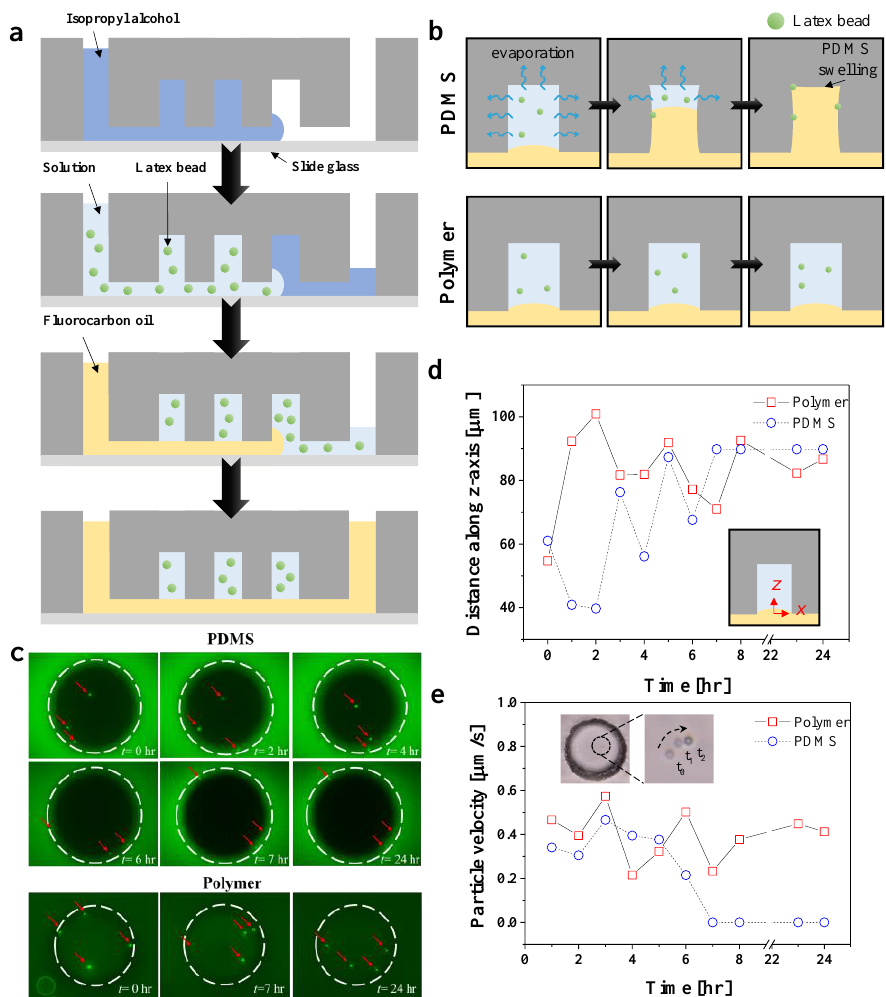
Figure 5. ( a ) Schematic illustration of particle compartmentalization. In order to visualize the evaporation of microchambers, latex beads expressing green fluorescence were diluted in distilled water. ( b ) Schematic illustration of the evaporation process inside microchambers in each channel. ( c ) Fluorescence images of microchambers containing fluorescent particles in each channel. Red arrows indicate fluorescent particles with a diameter of 1 µ m. Dashed white circles represent microchambers with a diameter and height of 100 µ m. ( d ) Vertical motion of fluorescent particles was quantified as a position along the z -axis. ( e ) Planar motion of the fluorescent particles was quantified as particle velocity. Particle displacement was measured for 5 s. Inset images show Brownian motion of particles in